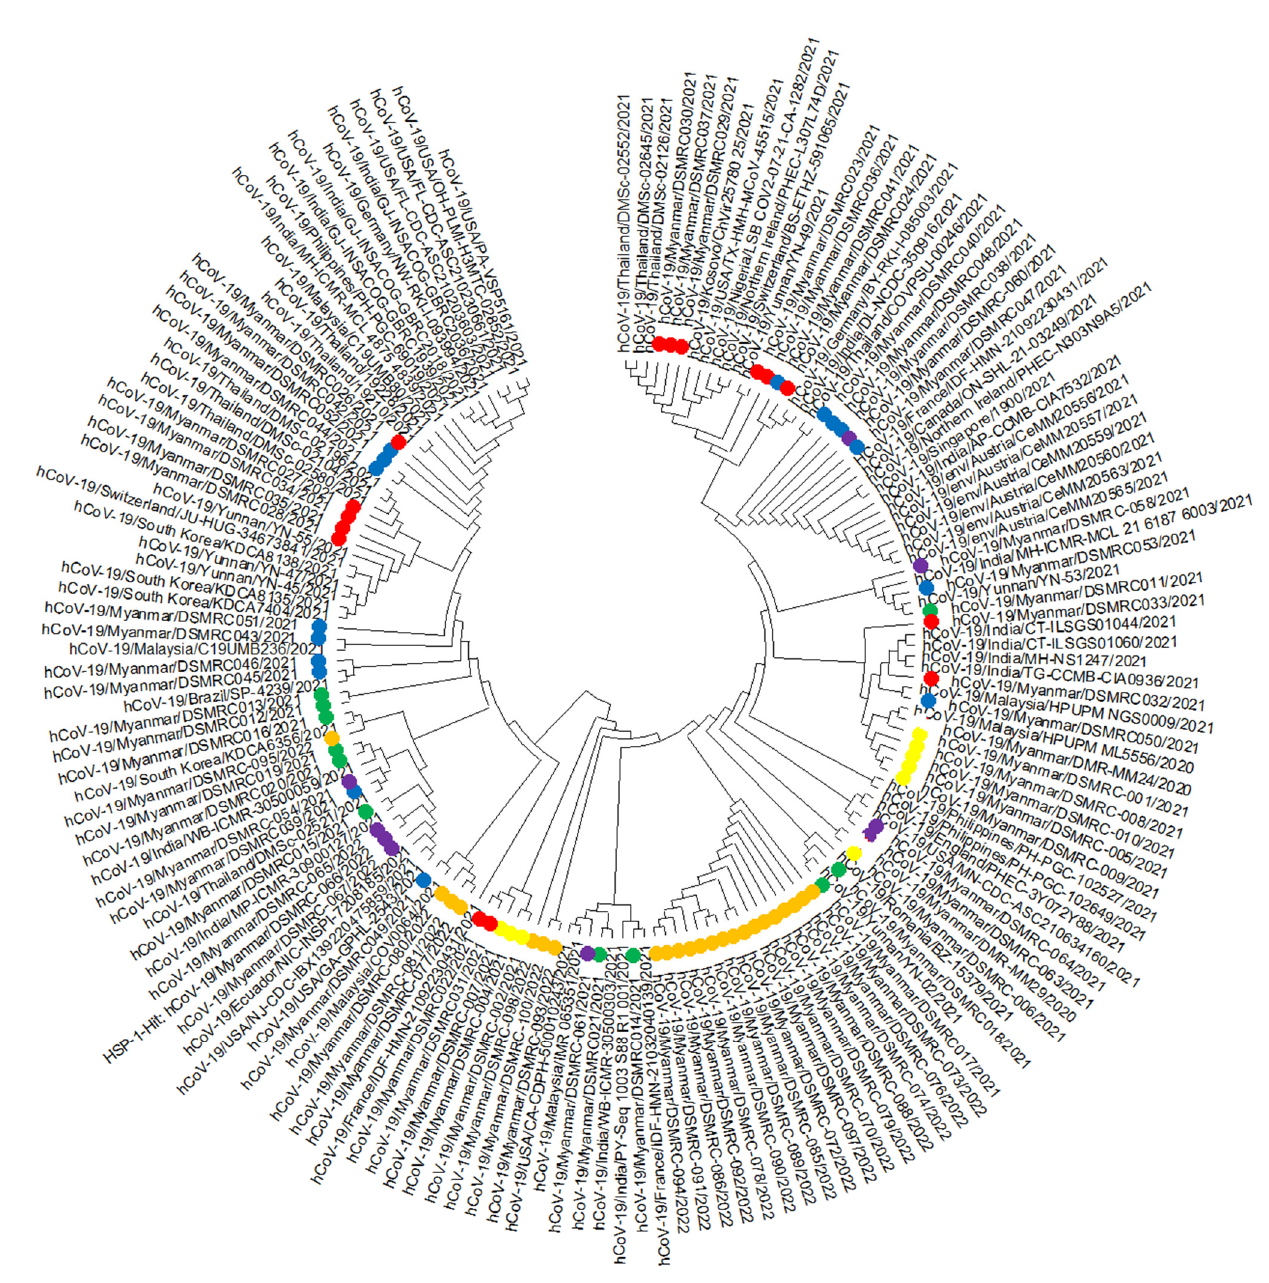
Figure 1. Phylogenetic tree comparing Myanmar SARS-CoV-2 sequences with 78 previously pub- lished sequences. Label: Yellow = First Run, Green = Second Run, Red = Third Run, Blue = Fourth Run, Purple = Fifth Run, and Orange = Sixth Run; We performed sequence alignment using MEGA version 7 with the MUSCLE algorithm, neighbor-joining analysis method, and the Kimura 2-parameter model with 1000 bootstrap replications for phylogenetic analysis.